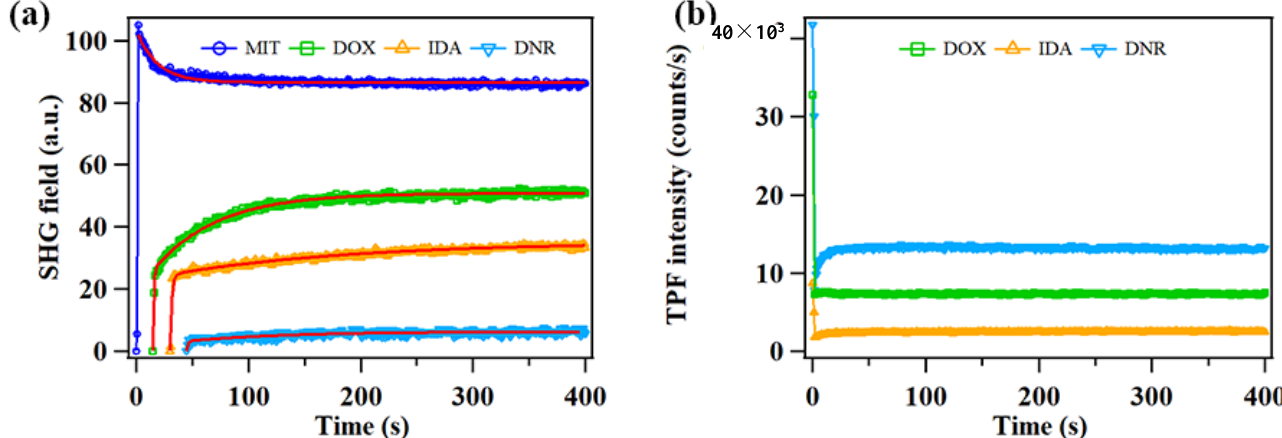
Figure 10. Time-dependent SHG field ( a ) and TPF intensity ( b ) curves obtained after the mixing of MIT, DOX, IDA, and DNR solutions with the DOPG vesicle solutions as shown in Figures 4, 5 and 9. The solid lines in frame ( a ) were from exponential (for MIT) or bi-exponential (for DOX, DNR and IDA) fittings. Some curves were shifted in the x direction to make the plot clear. Frame a is reproduced with permission [58]. Copyright 2020